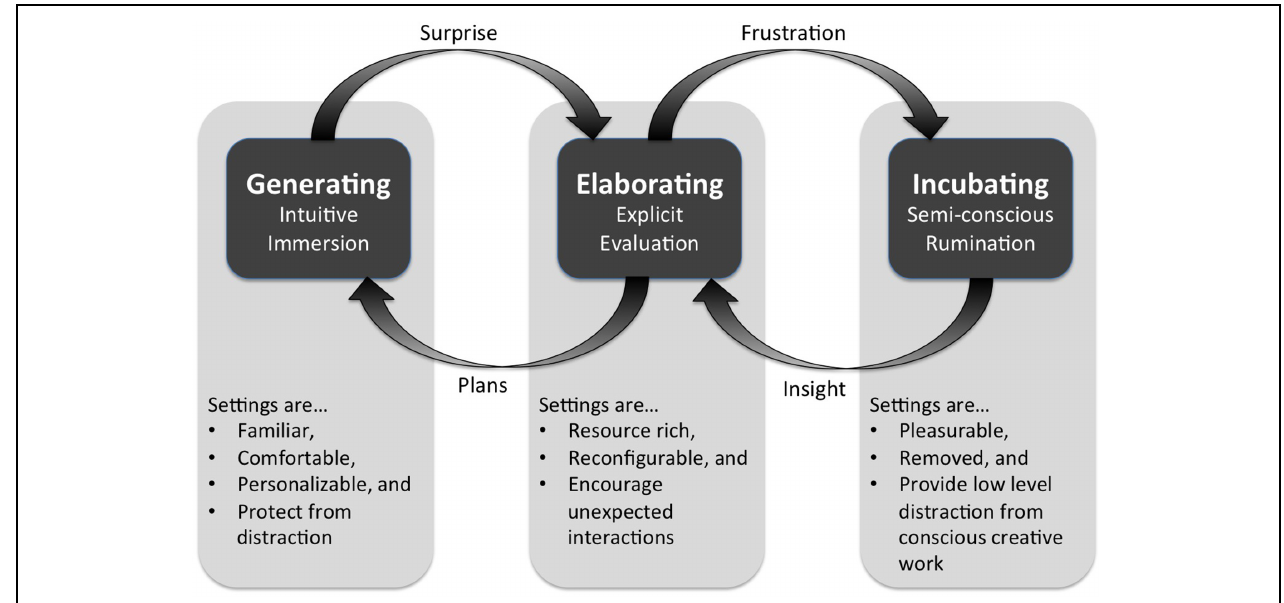
FIGURE 3 | Linking creative process and